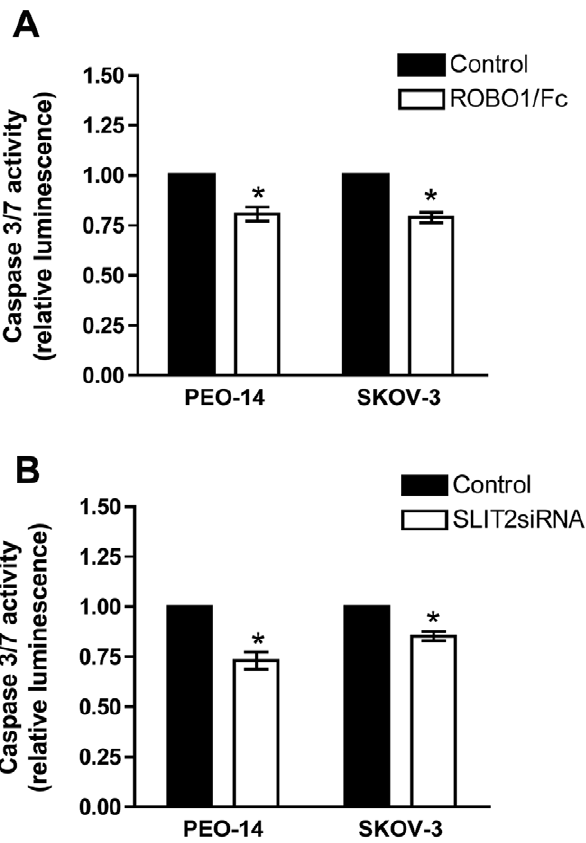
Figure 3. Inhibiting SLIT-ROBO signalling decreases apoptosis as measured by an activated caspase-3/7 assay. A ) Treatment with the ROBO1/Fc chimera reduced caspase-3/7 activity, when compared to treatment PBS/0.1% (w/v) BSA (Control) in both PEO-14 and SKOV-3 cells. B ) Transfection with SLIT2 siRNA reduced caspase-3/7 activity, when compared to treatment with a scrambled siRNA control. *= P ,